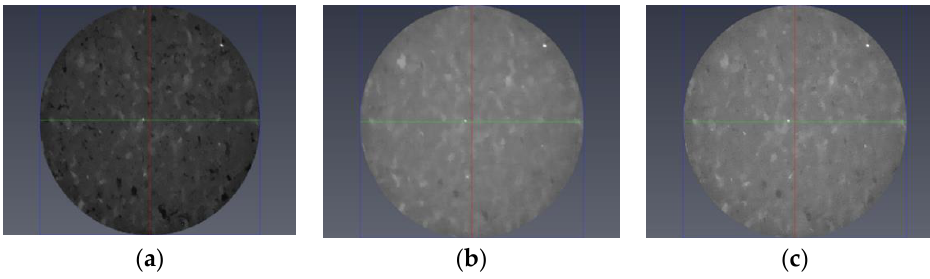
Figure 6. Distribution of fluid in the pore space under different states (gray represents rock, black represents oil, white represents minerals). ( a ) Dry rock sample. ( b ) Saturated oil (irreducible water). ( c ) Residual oil (CO 2 flooding oil).